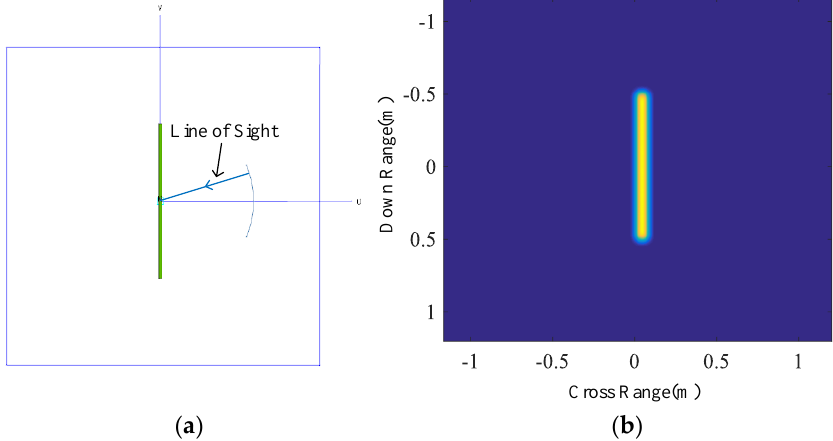
Figure 2. The imaging result of a metal rod under the condition that the incident direction is vertical to the flank occasionally during the acquisition. ( a ) Imaging scene. ( b ) SAR imaging result.